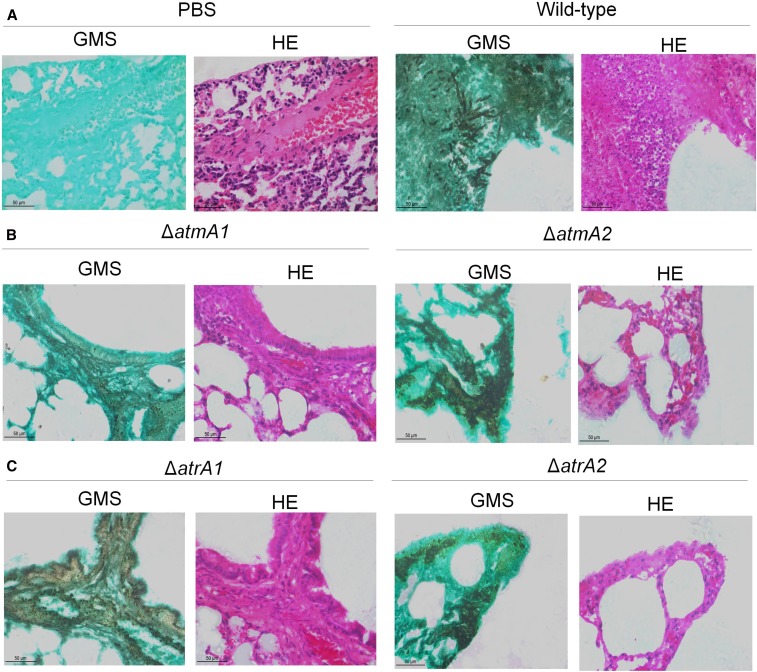
Histopathology of mice infected with A. fumigatus wild-type, and ΔatmA and ΔatrA mutant strains. (A) PBS and wild-type strain. (B) ΔatmA1 and ΔatmA2 mutants. (C) ΔatrA1 and ΔatrA2 mutants. PBS was used in the mock-infected animals. GMS and HE staining of lung sections of representative of infections. Bars, 50 µm. GMS, Grocott’s Methenamine Silver; HE, hematoxylin and eosin; PBS, phosphate-buffered saline.